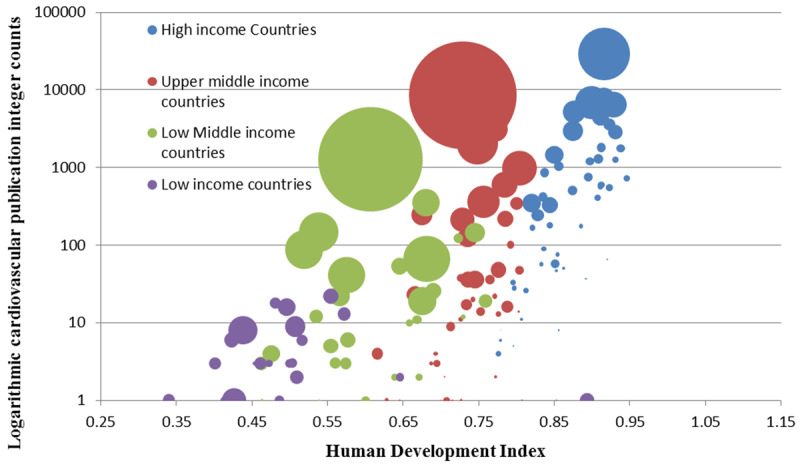
Logarithmic cardiovascular publication integer counts against Human Development index for the year 2013.Each bubble represents a country (n = 181). Size of the bubble represents the country population and color represents World Bank income group.